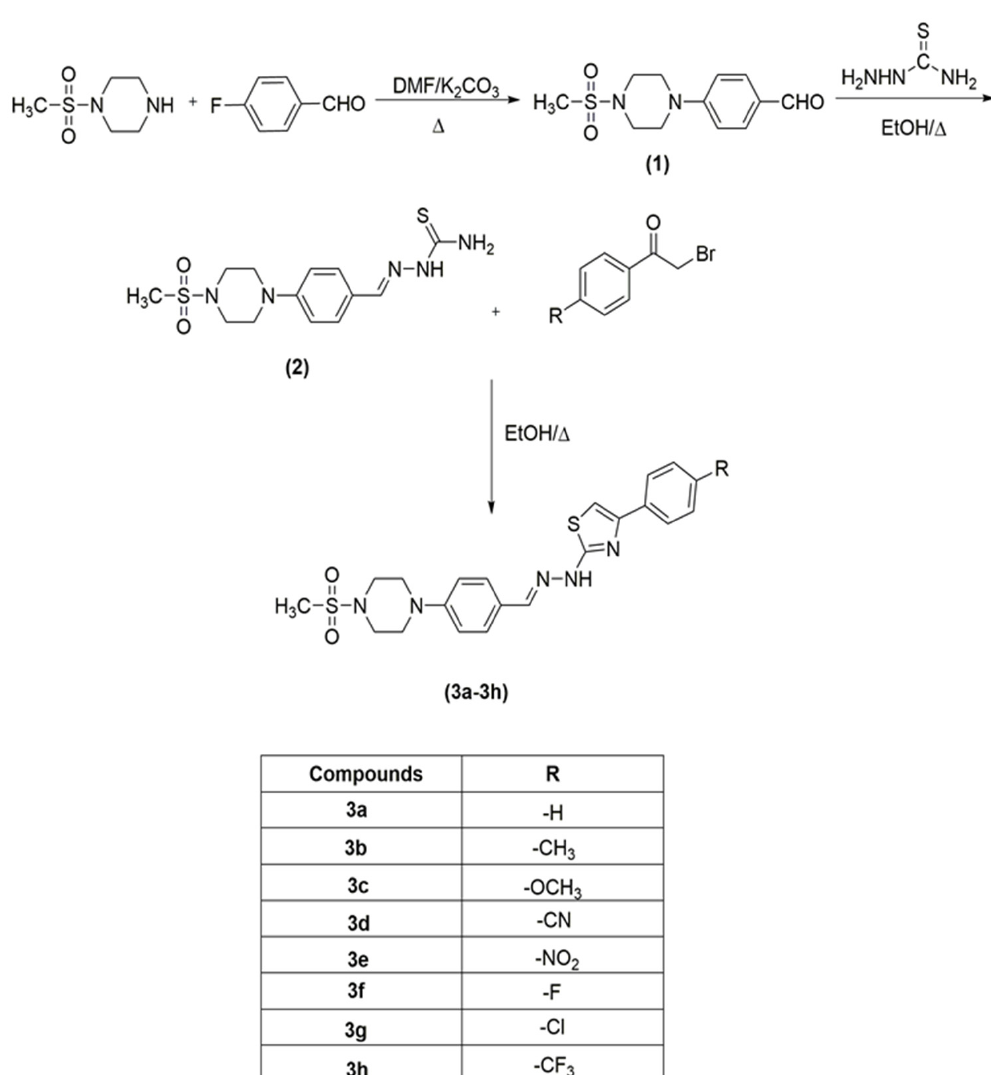
Figure 2. Synthesis pathway of target compounds ( 3a – 3h ).